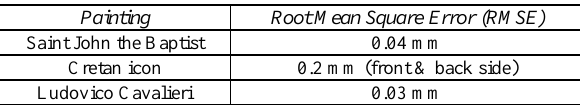
Table 2. RMSE values of the alignment procedures.